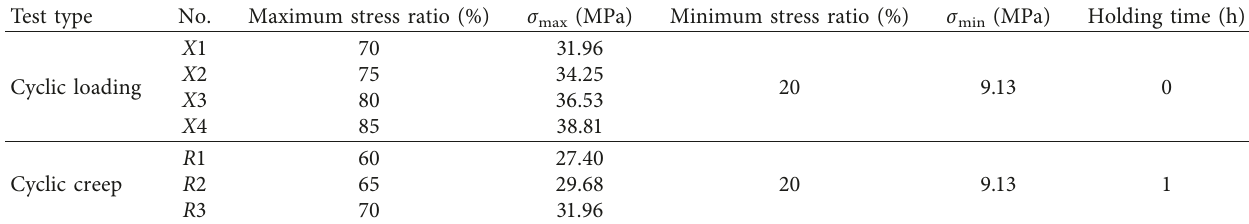
Figure 3: Path of loading and unloading for test. (a) Cyclic loading test and (b) cyclic creep test. Table 1: Scheme for test of cyclic loading and cyclic creep.